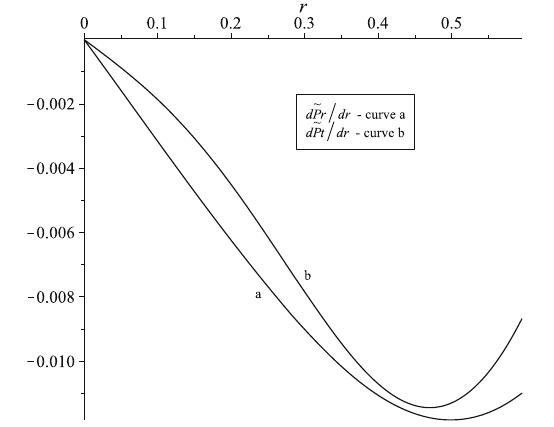
Fig. 9 Gradients of the pressures for the solution obtained with the first algorithm with F (cid:9)= 0 from the isotropic Gold III solution